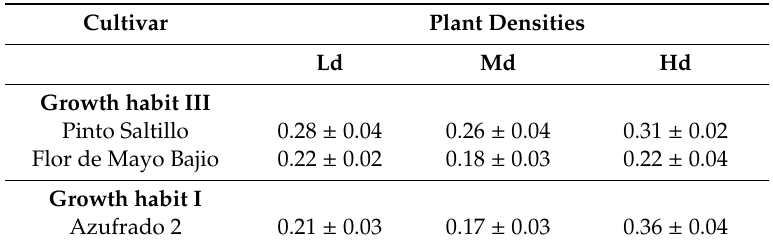
Table 2. Harvest index of dry bean ( Phaseolus vulgaris L.) cultivars established at 90,000 plants ha − 1 (Low density, Ld), 145,000 plants ha − 1 (Medium density, Md) and 260,000 plants ha − 1 (High density, HD) under rainfed conditions, with limited soil moisture (175 mm of precipitation) during the 2011 growing season in Pabellon de Arteaga, Aguascalientes,